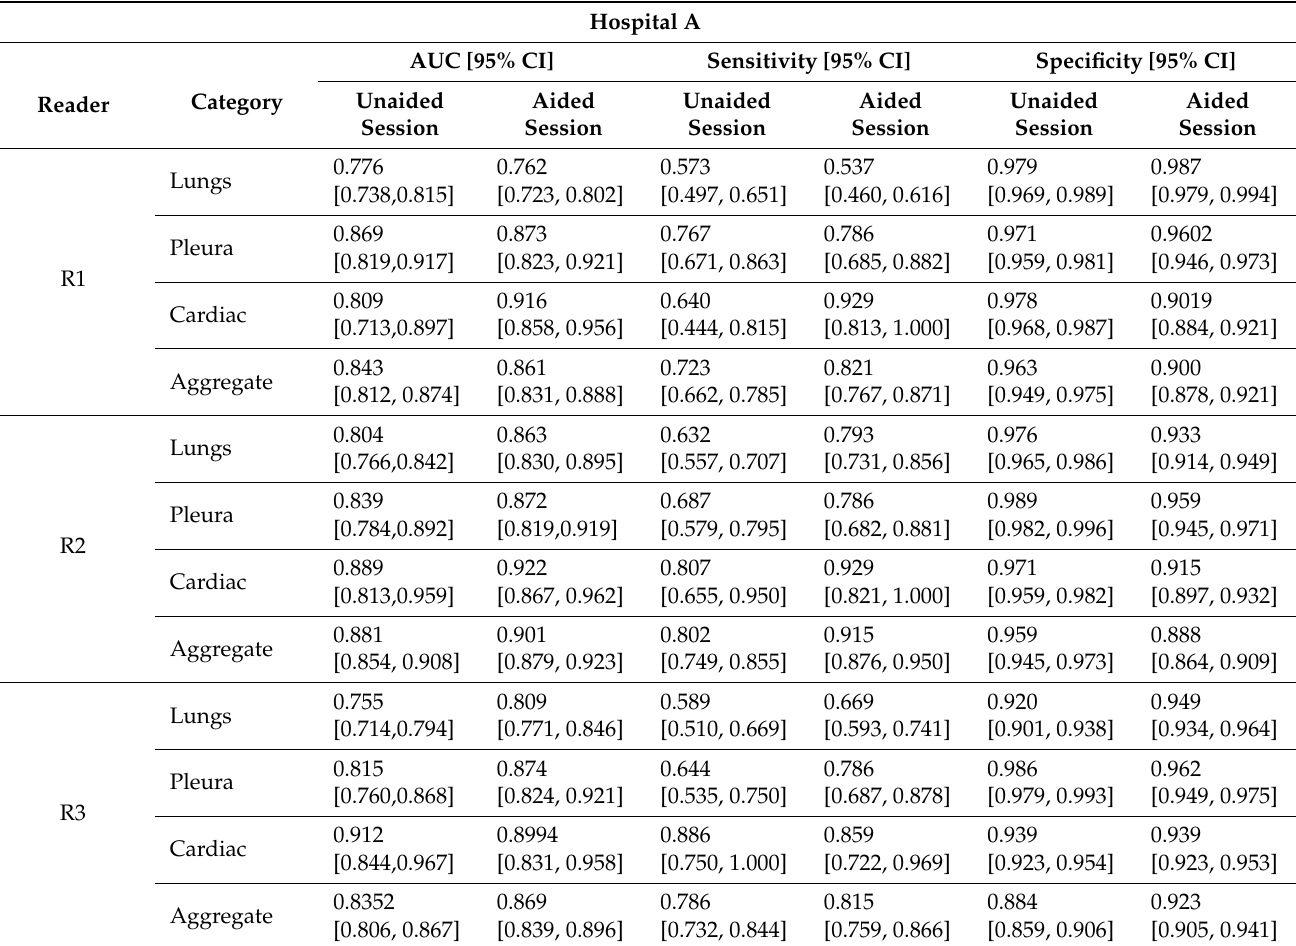
Table 4. Category-wise performance of the human readers in session 1 (unaided session) and session 2 (aided session) in 2 external validation